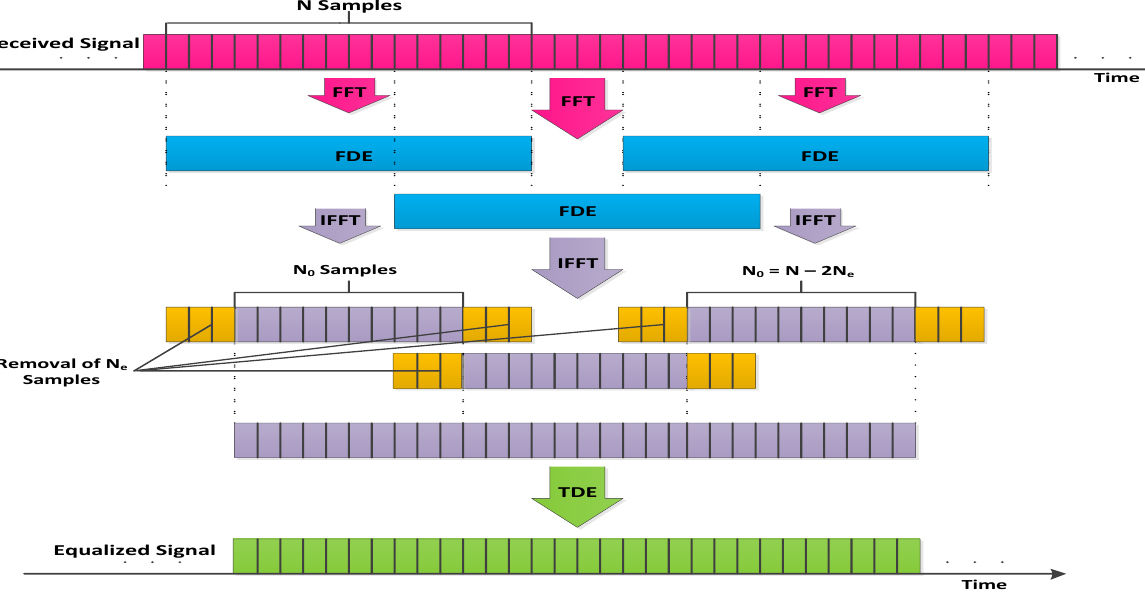
Figure 3. The proposed OFDE